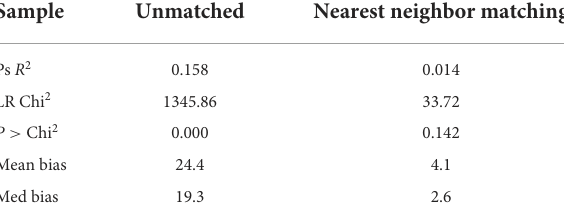
TABLE 3 Test for matching method